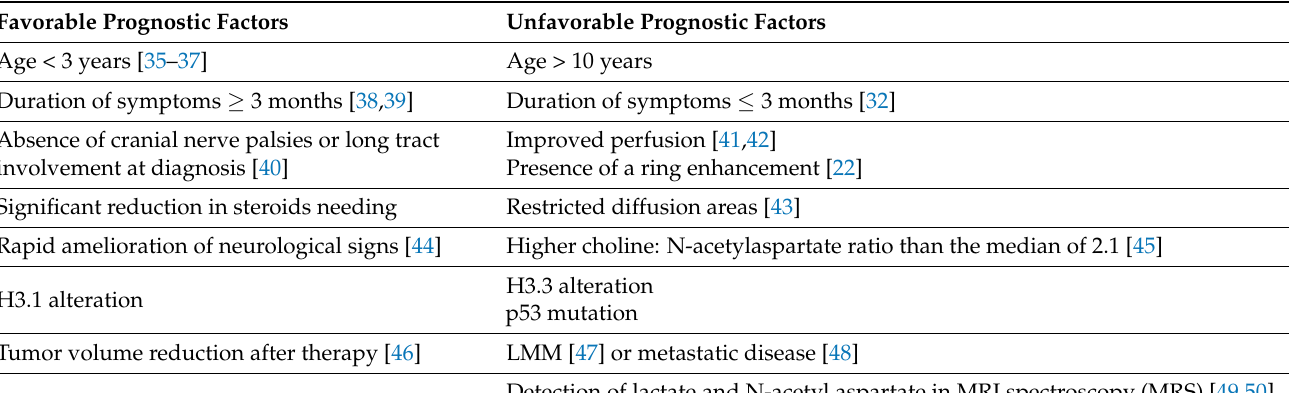
Table 1. Prognostic factors impacting survival in patients with